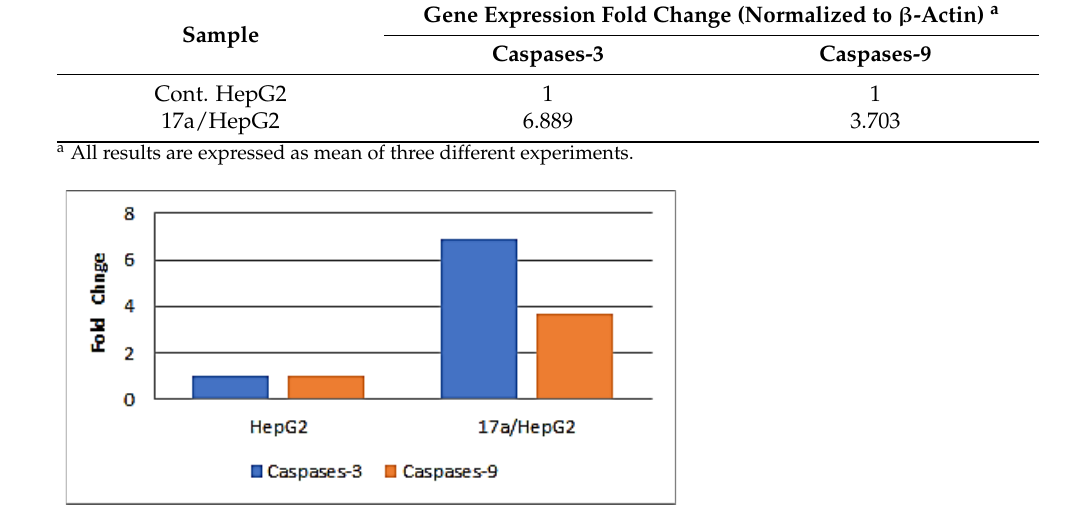
Figure 6. The gene expression fold change of caspases-3 and -9 in HepG2 cells treated with compound 17a .